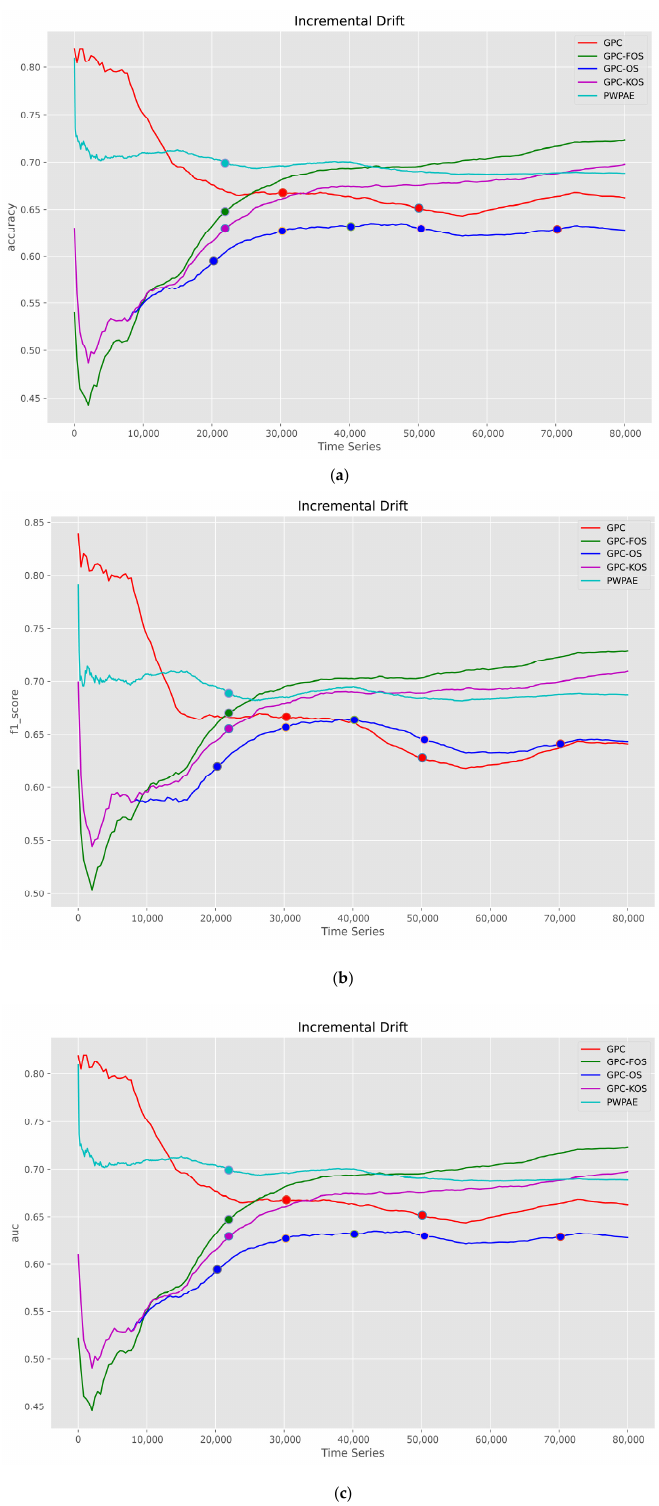
Figure 11. Visualisation of classification metrics as time series for an incremental type of drift—( a ) accuracy, ( b ) F1-score, ( c ) AUC. According to the results of blip drift in Figure 12, it was found that the best perfor- mance was achieved by PWPAE with values of 0.70, 0.62, and 0.68 for accuracy, F1-score,